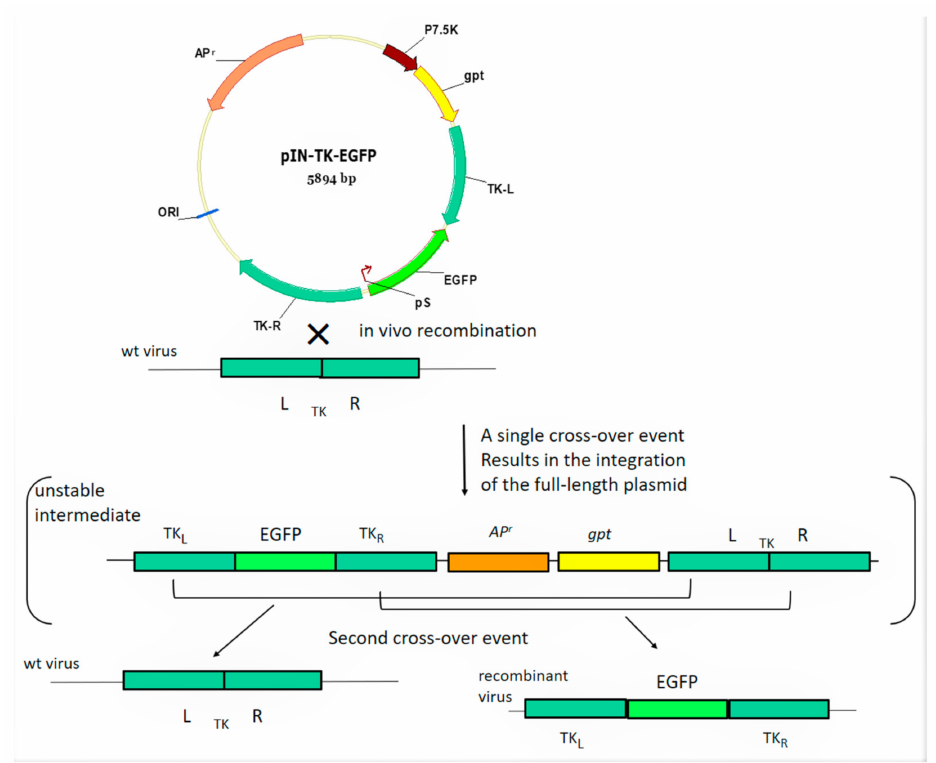
Figure 2. The general scheme for obtaining SPPV with the insertion of the green fluorescent protein gene into the thymidine kinase gene (explanation in the text).